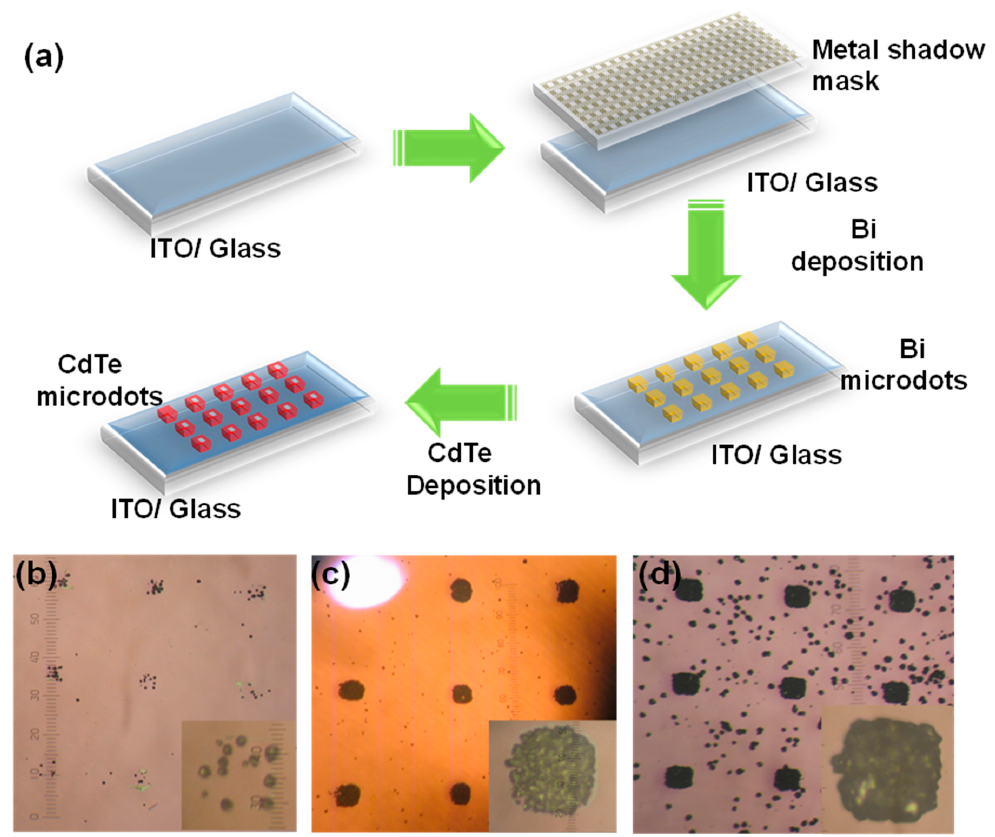
Figure 5. ( a ) Schematic of the fabrication process for the CdTe microdots arrays. Optical microscopy image of grown CdTe microdots arrays at different precursor to substrate distance ( b ) 15 cm, ( c ) 10 cm and ( d ) 5 cm.